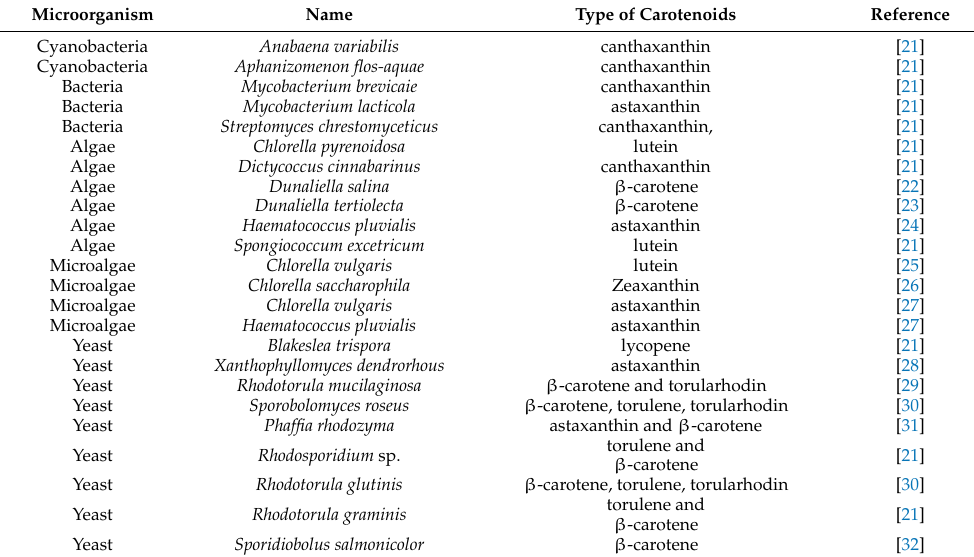
Table 1. Table showing various sources for microbial